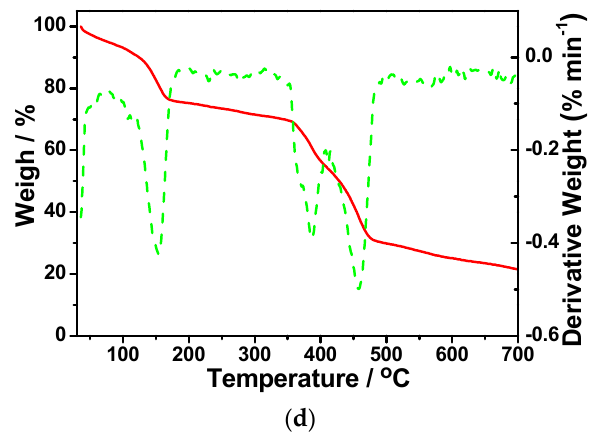
Figure 4. ( a ) IR spectra of 1 – 3 . The thermogravimetric data and DTG analysis for 1 ( b ), 2 ( c ), and 3 ( d ).